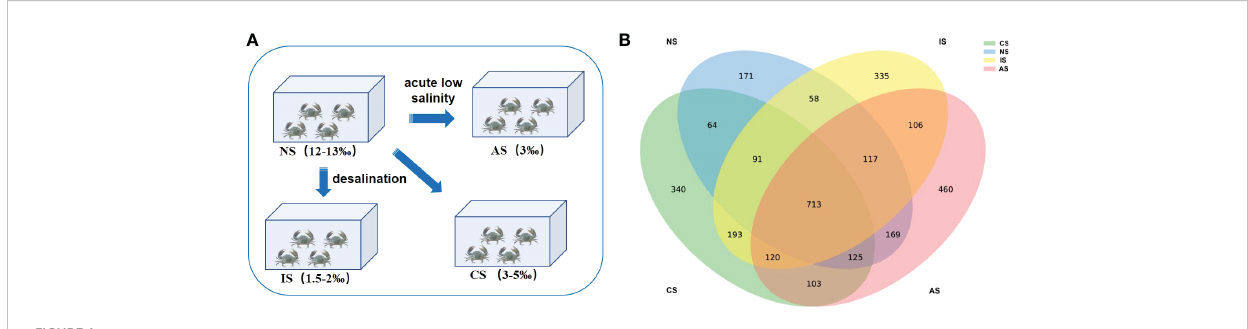
FIGURE 1 Data overview. (A) Experimental design; (B) Venn diagram of the